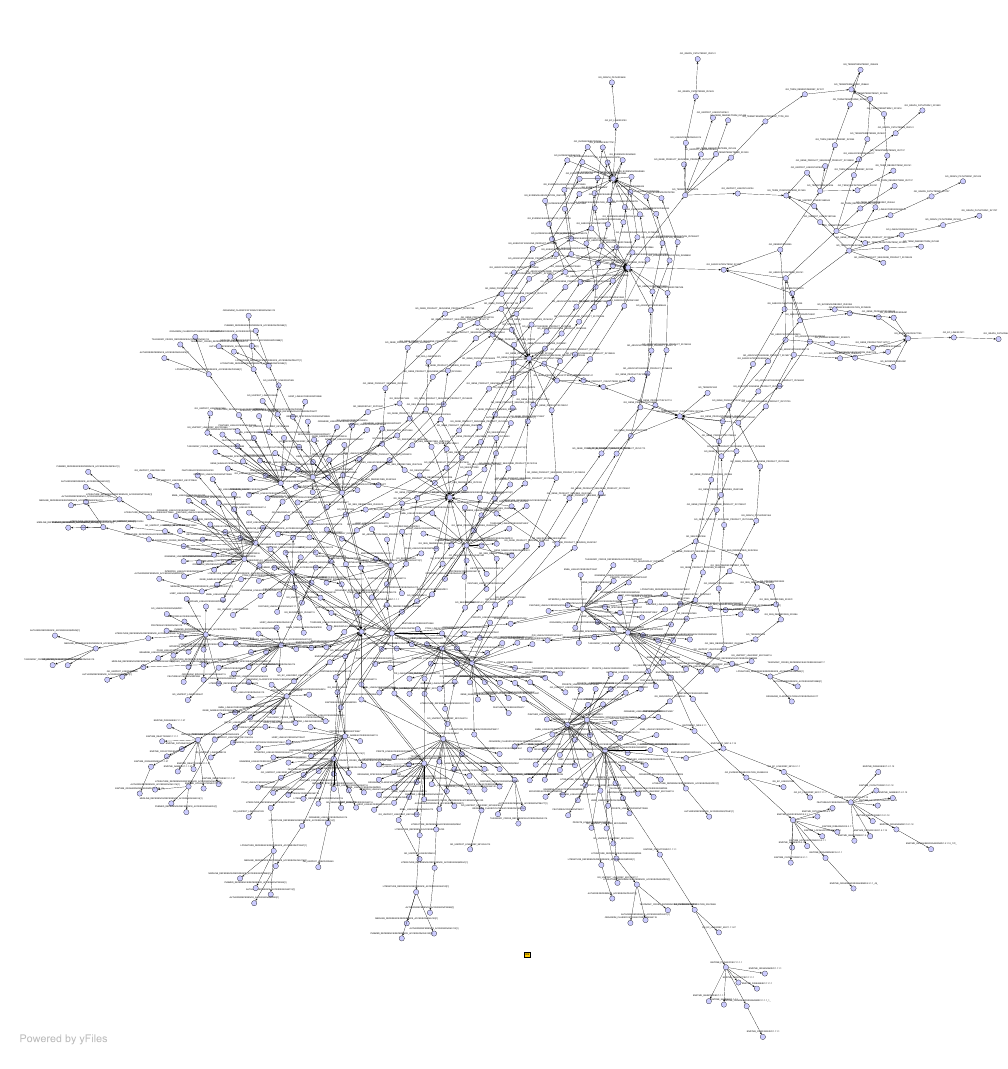
Figure 4: data network of enzymes in barley showing catalytic activity in glycolysis (high- resolution